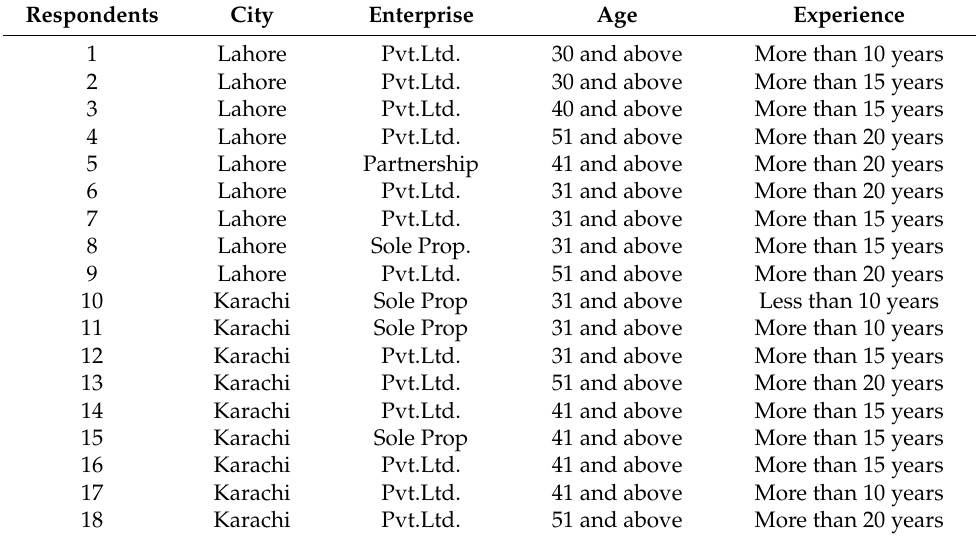
Table 1. Interviewee